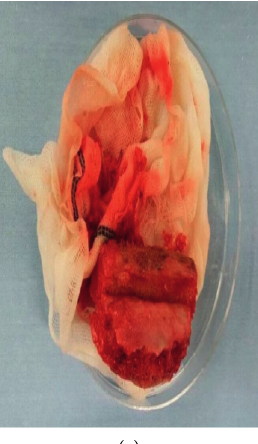
Figure 2: A 75-year-old male with L4/L5 pyogenic spondylitis underwent endoscopic debridement. Because low back pain did not improve postoperatively, anterior reconstruction surgery with an iliac autograft was performed. (a) Preoperative sagittal CT scans revealed de- structive endplate at the L4/L5 level. (b) Post-endoscopic surgery sagittal CTscans showing further bone destruction. (c) Post-open surgery sagittal CT scan view showing the bony fusion without severe kyphotic deformity.(d, e) Intraoperative view and iliac autograft; minimally invasive surgery was performed via the direct lateral retroperitoneal approach, and the large defect due to debridement was reconstructed with the strut bone collected from the ilium.